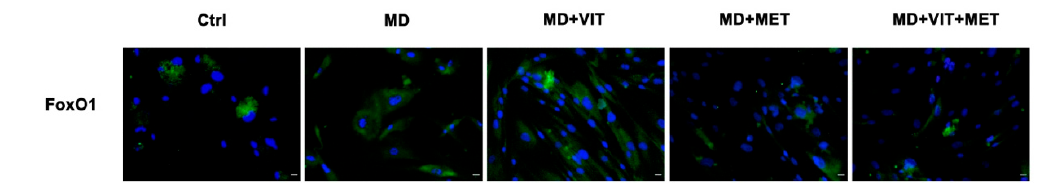
Figure 5. Immunohistochemistry analysis of FoxO1 after 21 days of differentiation: Immunohistochemical analysis of the expression of FoxO1 was performed in ADSCs cultured in the presence of adipogenic differentiation medium (MD), or in MD plus vitamin D (MD+VIT), or in MD plus metformin (MD+MET), or in MD with both metformin and vitamin D (MD+VIT+MET), as compared to control untreated cells (Ctrl). The figures are representative of two different independent experiments with three technical replicates. For each differentiation marker, fields with the highest yield of positively stained cells are shown. Nuclei are labelled with 4,6-diamidino-2-phenylindole (DAPI, blue). Scale bars: 40 µm.